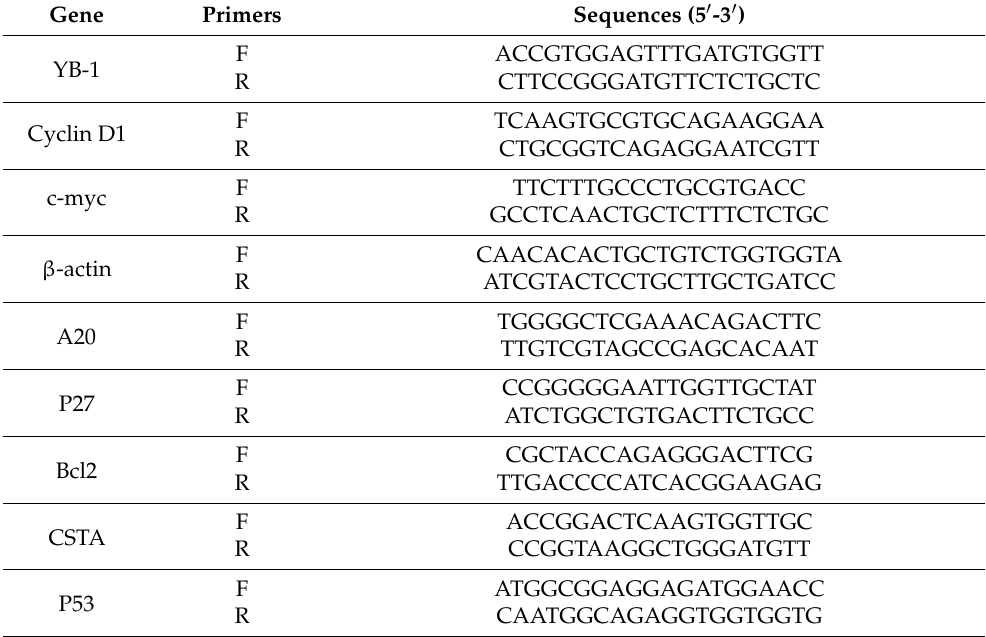
Table 2. Primers for semi-quantitative